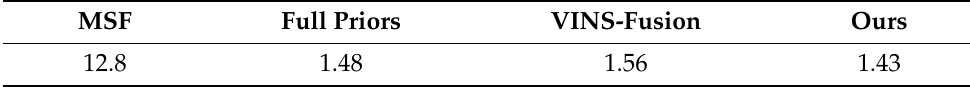
Table 4. Median heading errors (deg) tested on KAIST dataset.